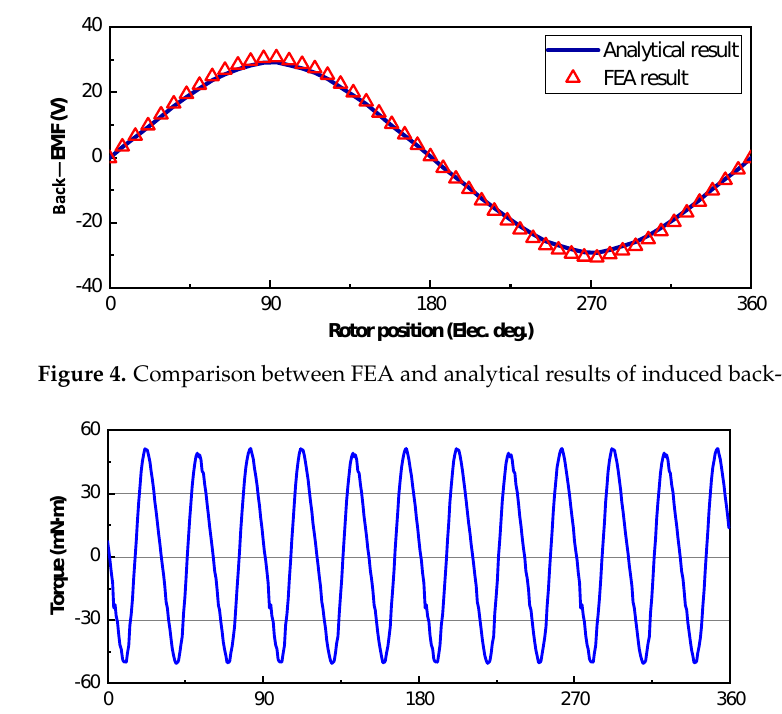
Figure 3. Relationship between normalized amplitude of harmonic component in back-EMF with its order.